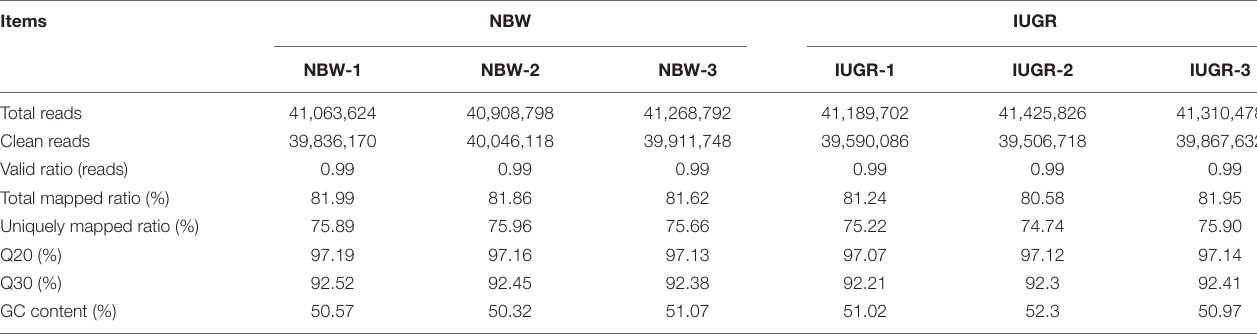
TABLE 1 | Summary of transcriptomic results.